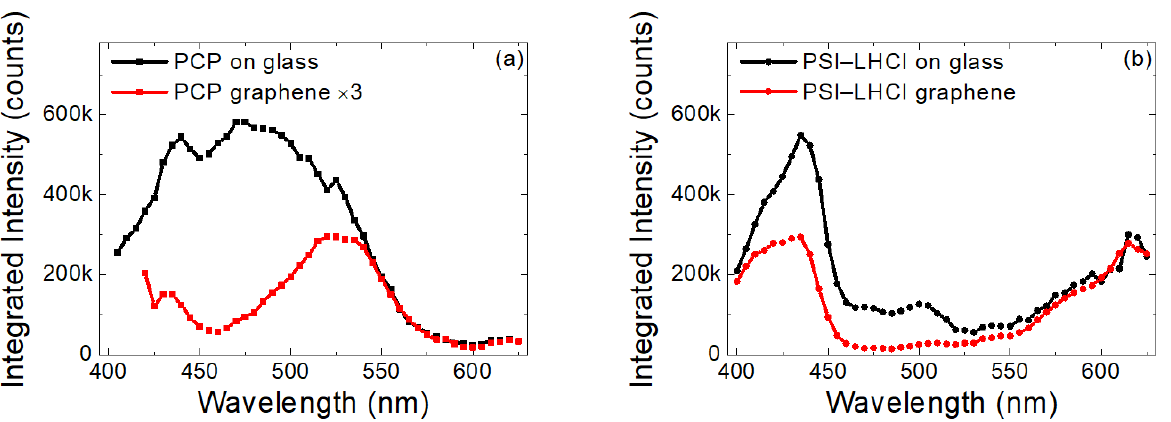
Figure 3. Photoluminescence excitation spectra of PCP ( a ) and PSI–LHCI ( b ) layers deposited on glass (black) and graphene substrate (red).